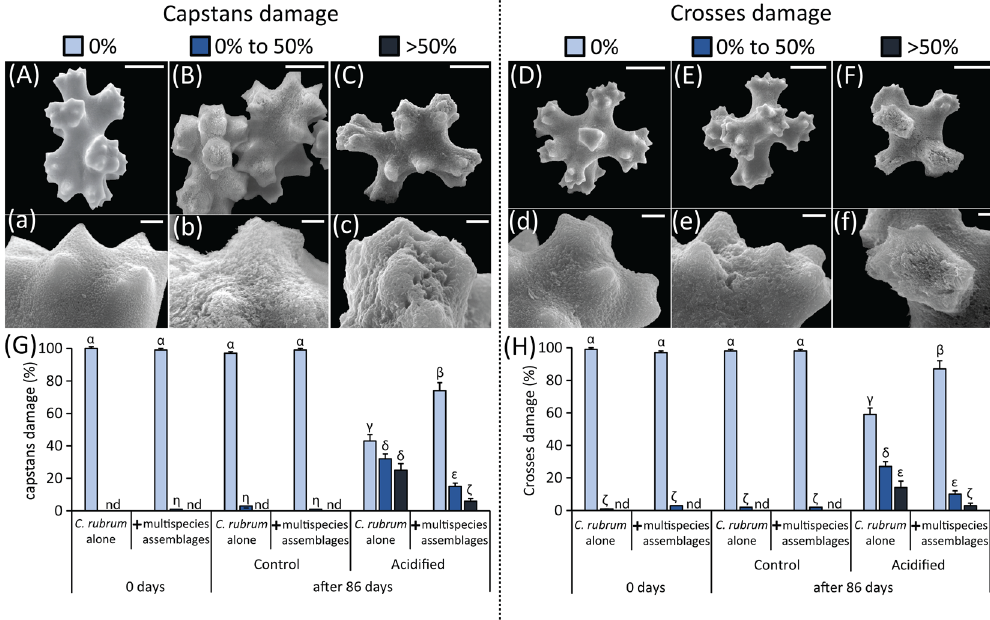
Figure 2. Impact of acidification on the red coral sclerites. Reported are the Scanning Electron Microscopy images of the red coral’s sclerites, including either capstans ( A – C and respective enlarged details a-c) or crosses ( D – F and respective enlarged details d-f), and indicative of different levels of damage ranked ( A ,a and D ,d: < 0% damage; B ,b and E ,e: between 0% and 50%; C ,c and F ,f: > 50%). The bar plots show the frequency of the different levels of damage to red coral capstans ( G ) or crosses ( H ) for the different experimental systems [i.e., acidified and non-acidified control mesocosms, containing C. rubrum alone or in association with the coralligenous multispecies assemblages, at the start (0 days) and at the end (86 days) of the experiment]. Reported are average values and SDs (n.d., none detected). Greek letters are used to highlight the significant differences (p < 0.01) among the reported values, with α > β > γ > δ > ε > ζ > η in panel ( G ), and α > β > γ > δ > ε > ζ in panel ( H